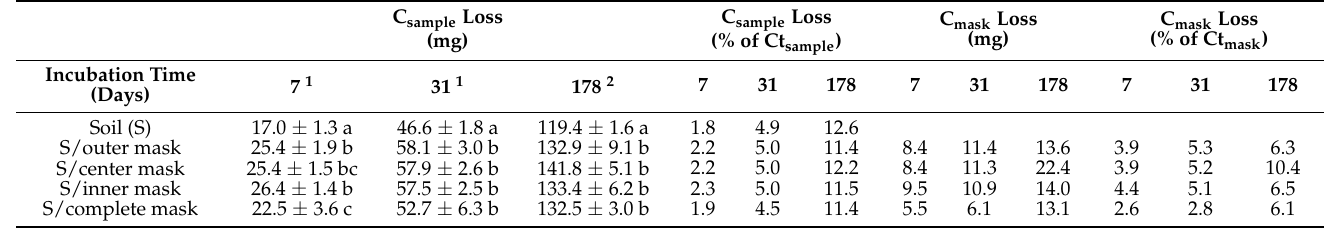
Table 3. Carbon (C) loss of total C of soil–mask mixtures (Ct sample ) (mg and % of Ct sample ) after 7, 31 and 178 days of incubation in a RESPICOND Apparatus IV at 25 ◦ C. The C loss of the respective masks (mg) was calculated from the difference of the loss in the pure soil sample and the soil–mask mixtures (mg) and related to the total C of the mask (Ct mask ) before incubation. Ct soil describes the carbon content of the pure soil. C sample Loss